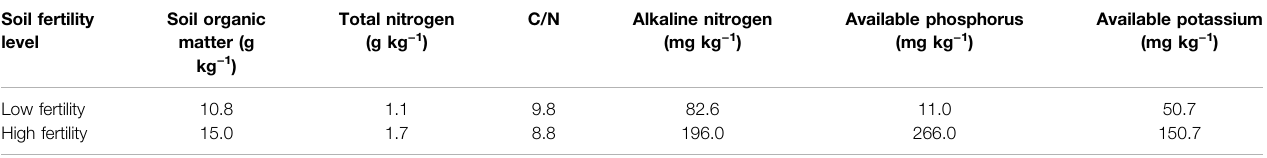
TABLE 1 | Basic characteristics of the tested soil.